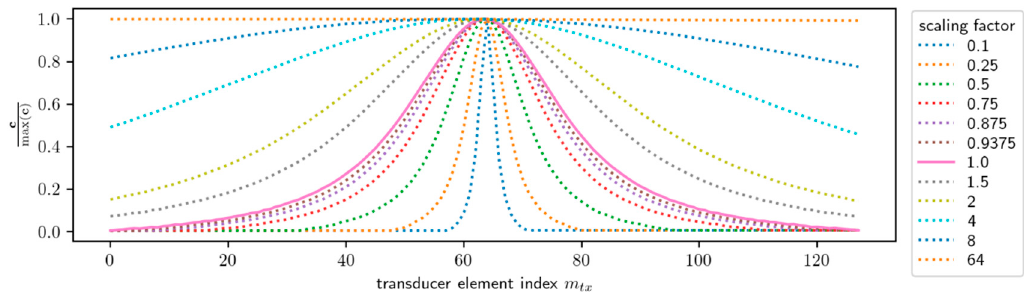
Figure 6. Plot of the energy distributions over the elements indices gained by linearly interpolating c to a scaled axis. The original distribution, which reflects the c obtained for the region of interest in Figure 4c, is given by the scaling factor 1.0 . The distribution is scaled to emulate the misalignment of c and investigate the impact on the reconstruction.